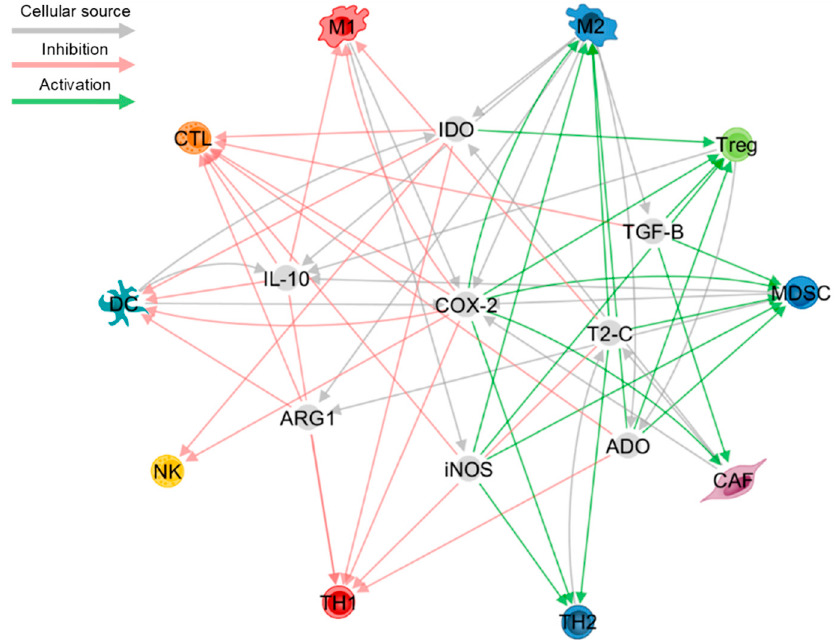
Figure 1. The immune circuitry within ‘cold’ tumour niches is governed by soluble factors such as cytokines, growth factors and enzyme-regulated metabolites. Immune and stromal cell types send and receive signals within the tumour milieu which culminates in the generation of an immune privileged TME that impairs anti-tumour immunity. Abbreviations: T2-C: type-II inflammatory cytokines, IDO: indoleamine 2,3-dioxygenase, TGF-B: transforming growth factor β , ADO: adenosine, ARG1: arginase-1, iNOS: inducible nitric oxide synthase, and IL-10: interleukin-10.